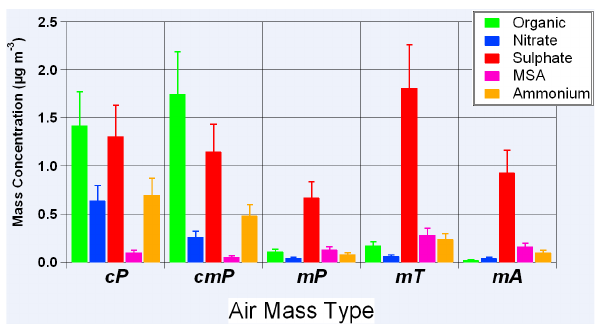
Fig. 8. Aerosol black carbon mass derived from the Aethalometer A-16 and the the MAAP. Fig. 9. AMS-derived organic, nitrate, sulphate, MSA, and ammo- nium mass as a function of air